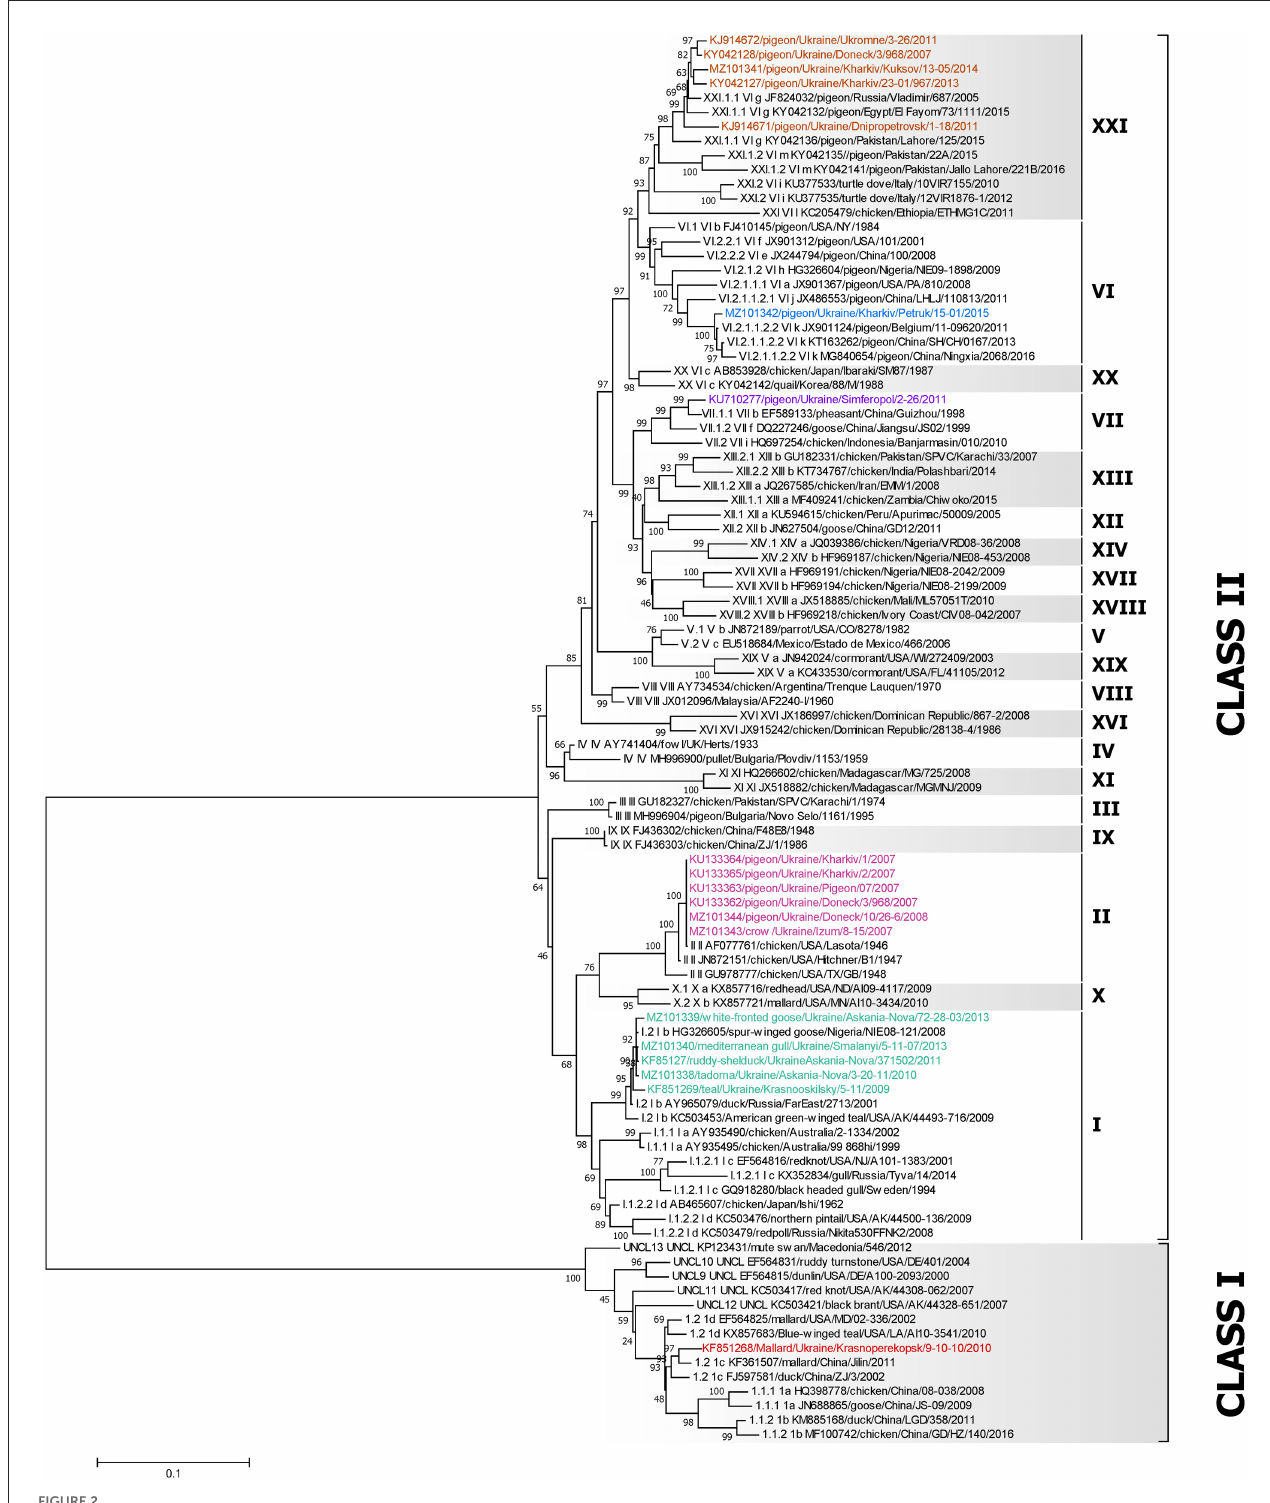
FIGURE2 Phylogenetic analysis of NDV class I and II isolates based on the complete fusion gene sequences constructed with the maximum likelihood method, based on the general time-reversible model in MEGA v. 7.0.26. The percentage of trees in which the associated taxa clustered together in the bootstrap test (1,000 replicates) is shown next to the branches. The analysis involved 98 nucleotide sequences, 79 represent all class I and II sub-genotypes described by Dimitrov et al. ( 5) and 19 were collected from wild and synanthropic birds in Ukraine. All positions containing gaps and missing data were eliminated. There were a total of 1,661 positions in the final data set. The isolates used in this study are shown in colors. The Roman numerals presented in the taxa names in the phylogenetic tree represent the respective sub-genotype for each isolate, followed by the GenBank identification number, host name, country of isolation, strain designation, and year of isolation (if